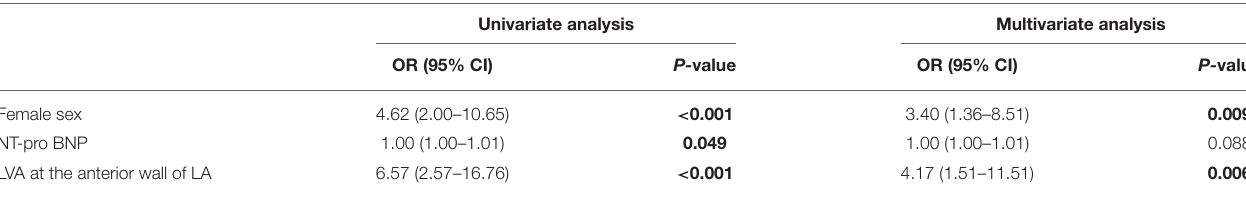
TABLE 3 | The logistic regression analysis to identify risk factors associated with TE.